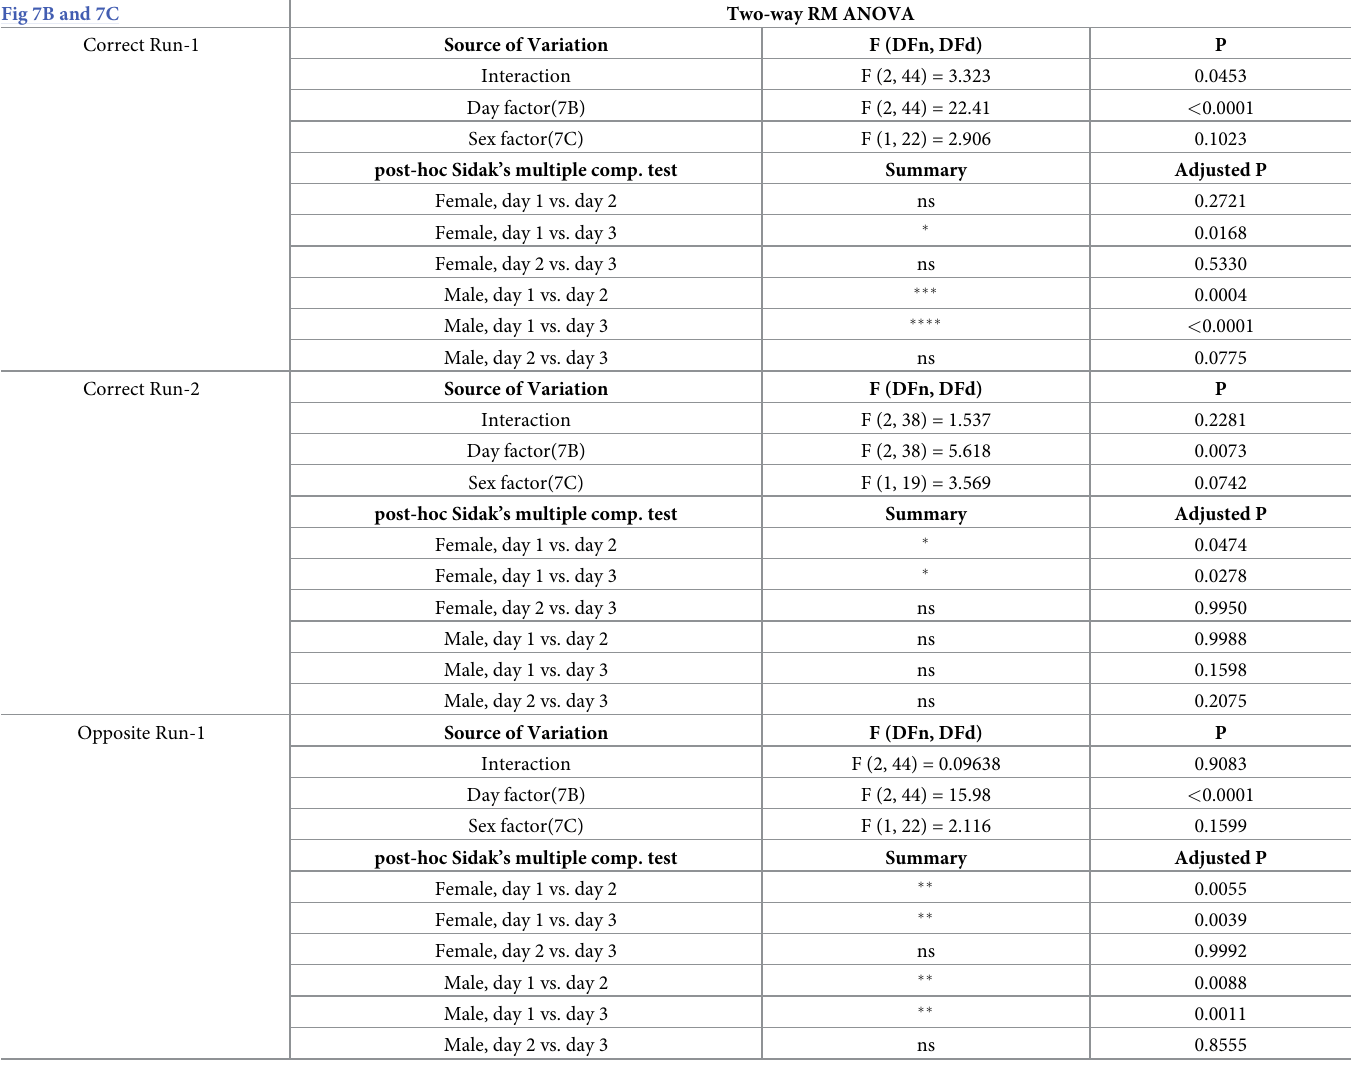
Table 10. Statistical analysis of data shown in Fig 7B and 7C for behavioral sequencing, cohort A, Run-1, and Run-2. Fig 7B and 7C Two-way RM ANOVA Correct